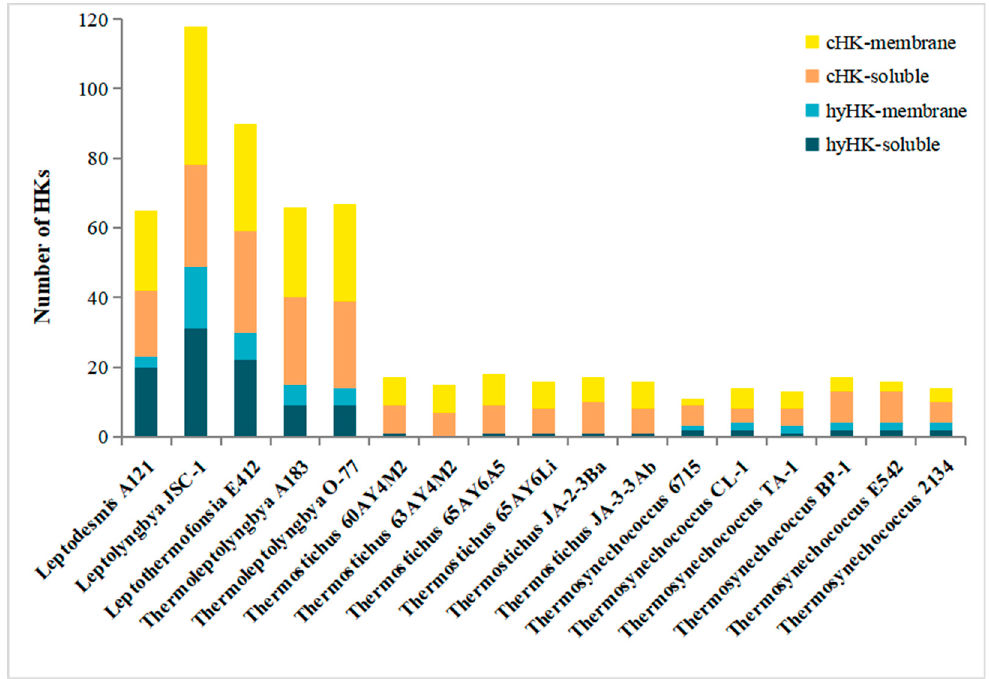
Figure 2. Predicted subcellular localization of HKs in the thermophilic cyanobacteria studied.